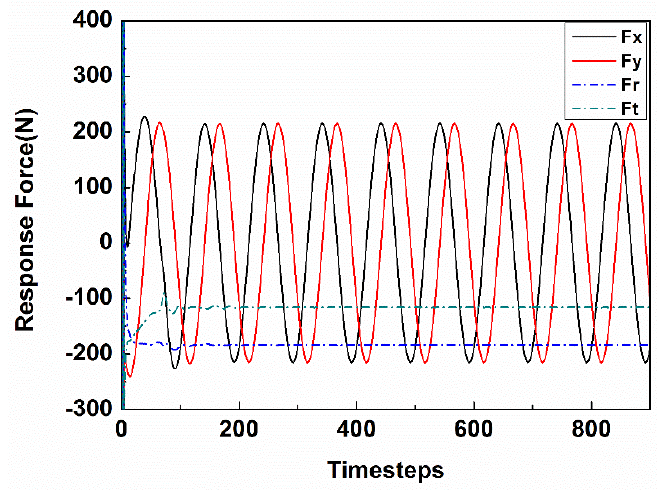
Figure 7. Response force on the rotor (PFR = 1).